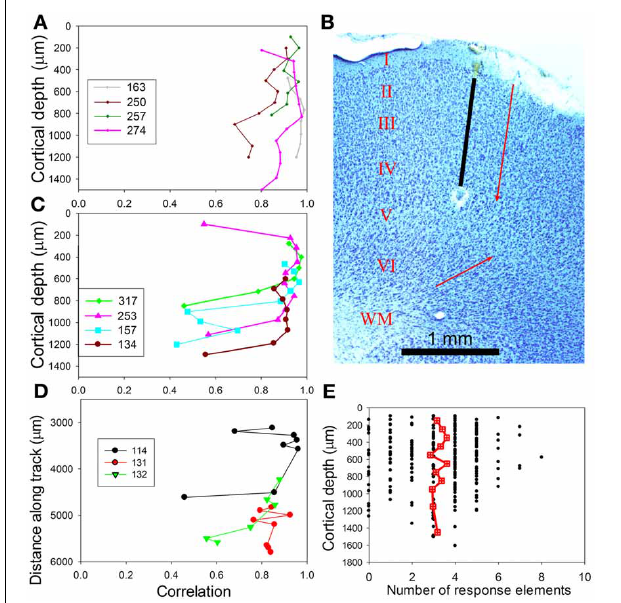
FIGURE 11 | (A) Similarity of recorded responses in tracks across AI(LF). For any one track the mean PSTH was correlated with the individual responses and the correlation values plotted against the distance along a track. These four tracks were oriented in a direction orthogonal to the cortical surface and were representative of eight tracks that mainly showed similar values over a distance of about 1mm. (B) Coronal section through AI(LF), stained for Nissl substance and showing the position of an orthogonal electrode track (black line) that has been extrapolated between the blood filled start of the track and an electrolytic lesion at the upper edge of layer V. The parallel red arrow indicates the orientation of the stacks of cells separated by bundles of myelinated fibers that indicate the orientation of cortical microcolumns in the outer layers. The red arrow pointing obliquely upwards indicates the orientation of cell columns in the deep layers. The cortical layers are indicated by Roman numerals and the white matter by WM. Part of layer I, above the red arrow, was injured during the experiment. (C) A further four orthogonal tracks that all show at least one sudden change in the type of response. (D) Three tangential tracks that also show a sudden change in response type if the track extends for more than about 1mm. (E) Scattergram plot showing the number of elements in chutter that units respond to over the range of depths sampled. The red square/cross symbols joined by a line indicate the running mean values for the number of elements and these remain fairly constant over the depth of AI(LF)